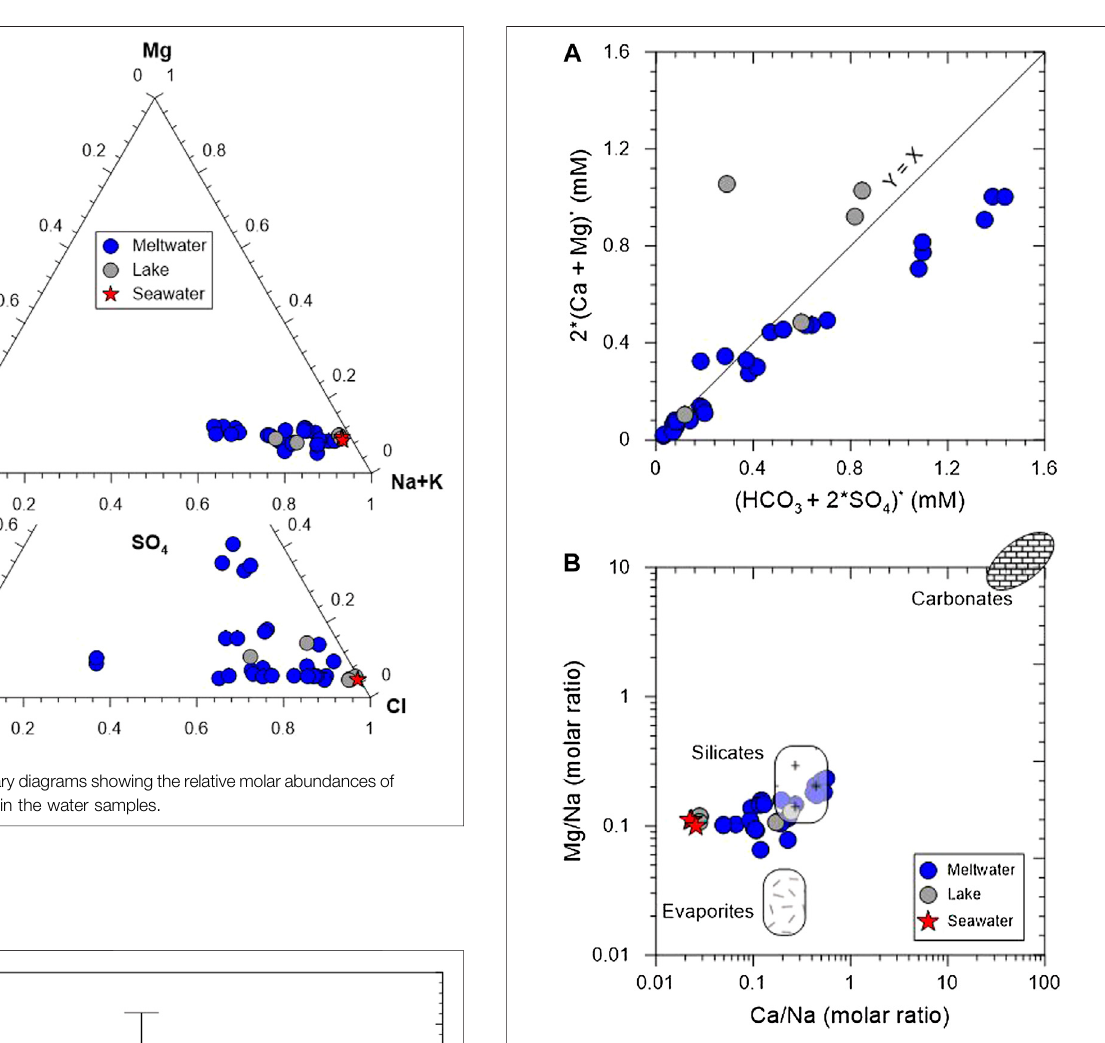
FIGURE 4 | Plots of (Ca + Mg)* and (HCO 3 + SO 4 )* (A) and Mg/Na versus Ca/Na (B) . Asterisk represents the concentration corrected for atmospheric input. Bedrock endmembers are from Gaillardet et al.